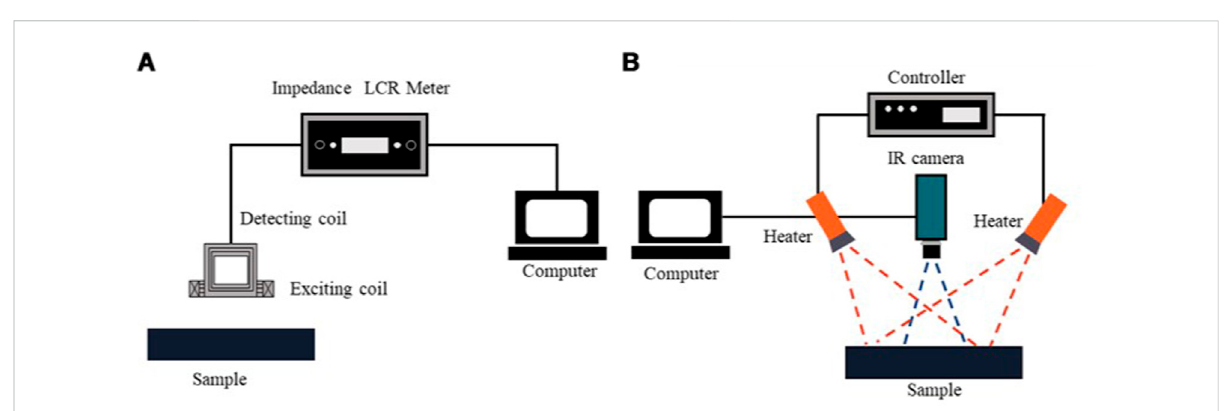
FIGURE 6 Schematic of system setups: (A) a ECT system setup with a theta probe; (B) an IRT system setup.